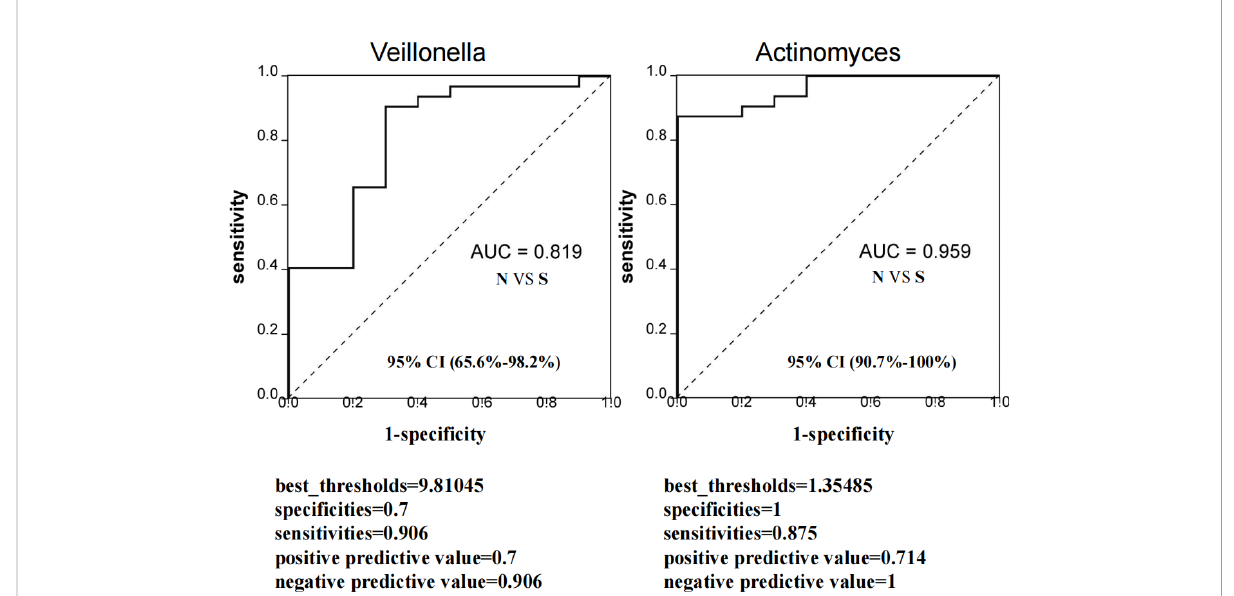
FIGURE 7 Evaluation of predictive ability of sellected microbiota biomarkers for severe delayed healing group. ROC curve represent the predictive ability of Veillonella and Actinomyces for S group. If AUC score is between 0.7 and 0.9, it represents a high accuracy. If AUC=0.5, it indicates that the diagnostic method is completely ineffective and has no diagnostic value. All samples including 10 S group and 32 N group were used to evaluate AUC values. The AUC value of Veillonella was 0.819 (95% CI: 65.6%-98.2%), and AUC value of Actinomyces was 0.959 (95% CI: 90.7%- 100%). The best_thresholds, speci fi cities, sensitivities, positive/negative predictive values were also